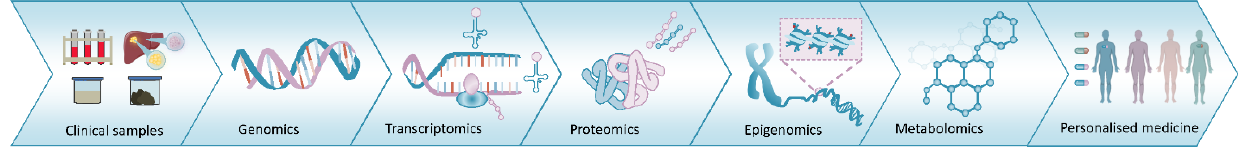
Figure 2. The omics pipeline. The information-flow from multiomics platforms can provide comprehensive information on health and disease, facilitating the realization of the goal of precision medicine.